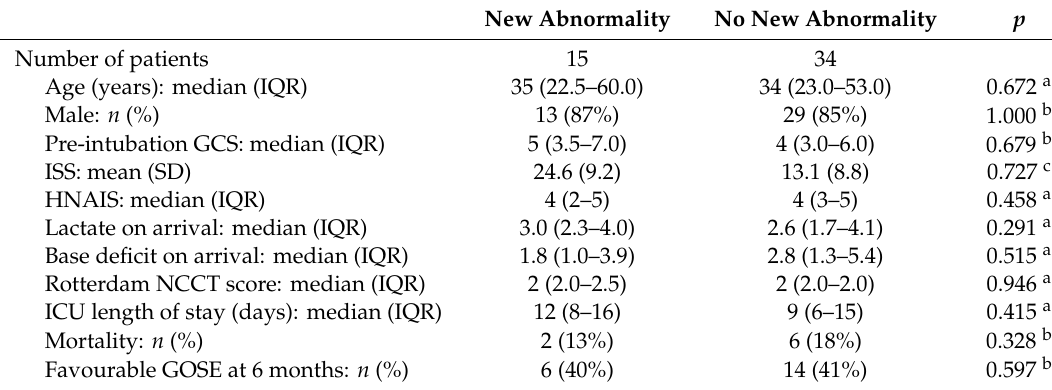
Table 4. Comparison of patients with a new perfusion abnormality detected by WBPCT versus those without new abnormalities.